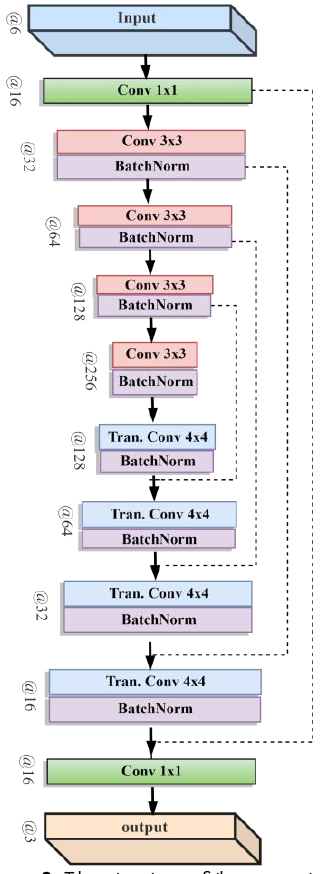
Figure 3. The structure of the generator.